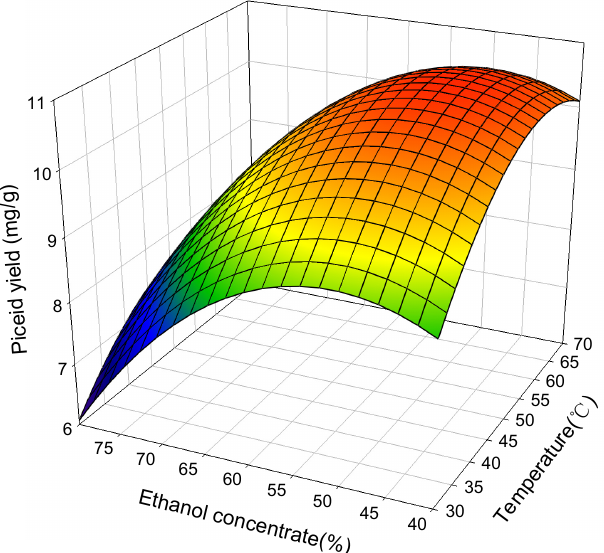
Figure 1. The effect of ethanol concentrate and temperature on the extraction yield of piceid at ultrasonic power of 120 W.